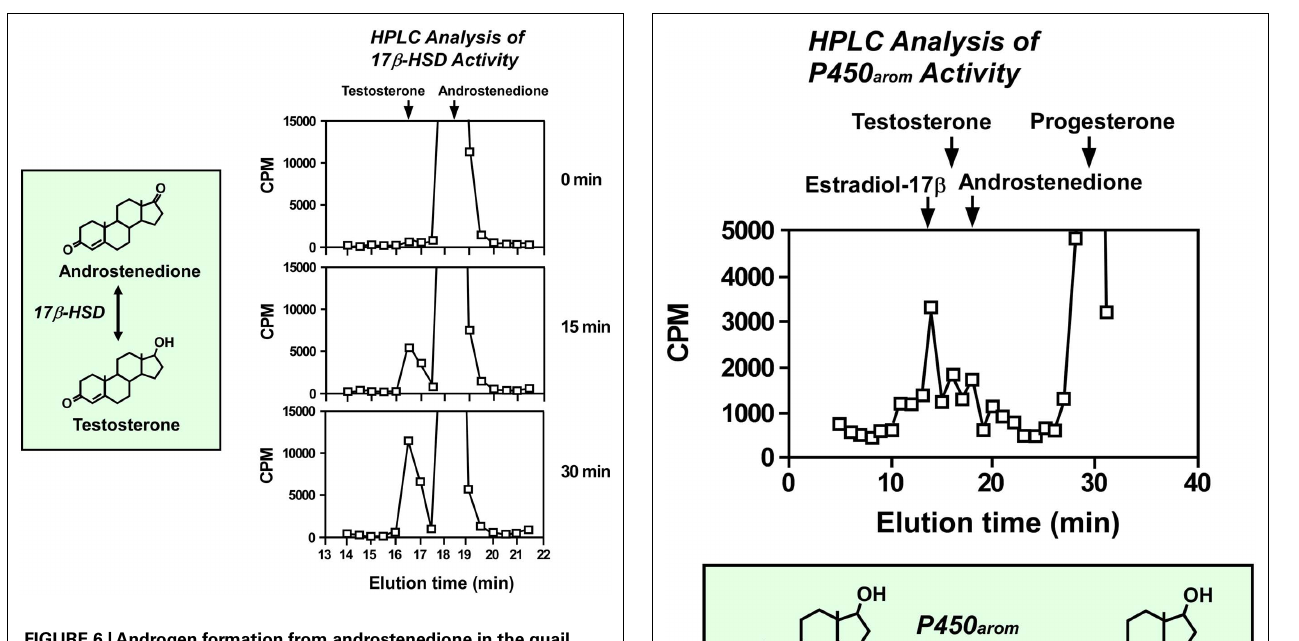
FIGURE 6 |Androgen formation from androstenedione in the quail brain. HPLC analysis of neurosteroids extracted from quail diencephalic slices after different incubation times with 3 H-androstenedione using a reversed-phase column.The column was eluted with a 30-min linear gradient of 40–70% acetonitrile, followed by an isocratic elution of 70% acetonitrile.The ordinate indicates the radioactivity measured in each HPLC fraction.The arrows indicate the elution positions of androstenedione and testosterone. See Matsunaga et al. (2002) for details. FIGURE 7 | Estrogen formation from androgen in the quail brain. HPLC